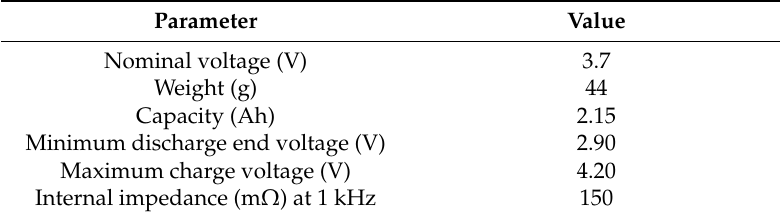
Table A1. Battery nominal parameters.